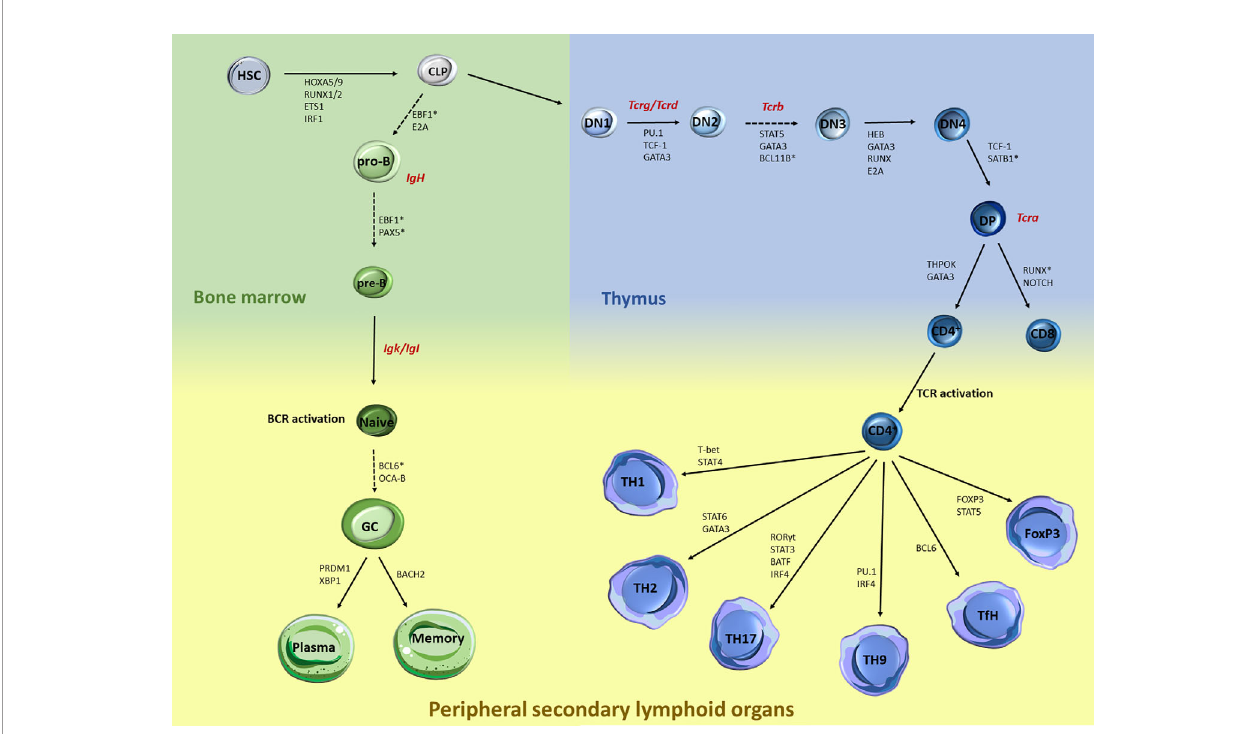
FIGURE 1 | Major stages during B and T lymphocyte speci fi cation and differentiation and key transcription factors that control each transition. B and T cell development and differentiation is a stepwise process that involves multiple speci fi cation steps, cell fate bifurcations and cell migration. Multiple TFs, including but not limited to those acting at the chromatin level, have been extensively documented in HSC. Within the bone marrow, the transition of CLP towards pro-B cells is mediated through EBF1 and E2A, while the further maturation of the pre-B cells is under the control of EBF1 and PAX5. Upon BCR activation, BCL6 and OCA-B are controlling the differentiation of naive to GC cells, while the latest developmental stages are mediated through BACH2 for memory B cells and PRDM1 and XBP1 for plasma cells. Similarly, T cell development is also regulated by a strong network of TF, cytokines and genome organizers that control chromatin dynamics and T cell lineage speci fi cation. Upon thymocyte migration, the early steps of the thymocyte development are mediated through the genome organizers SATB1 and BCL11B while TF such as PU.1, TCF1 and GATA3 mediate the generation of the DN1 cells. The transition from the DN2 to DN3 is mediated by the STAT5, GATA3 and BCL11B, while RUNX, GATA3, HEB and E2A mediate the DN3 and DN4 transition. TCF-1 is also the major TF driving the DN4 to DP transition. The last steps of the intrathymic development are mediated through the expression of ThPOK and GATA3 for the CD4 + cells and NOTCH and RUNX for the CD8 + cells. Upon TCR activation, expression of the master regulator T-bet via STAT4 signaling leads to TH1 differentiation, while STAT6 and GATA3 regulate the TH2 differentiation. Activation of STAT3 and ROR g leads to TH17 cells, while IRF4 and PU-1 induce the differentiation towards TH9 cells. Activation of Bcl-6 induces the differentiation of naive CD4 + T cells into TfH. Differentiation of the Tregs is controlled by the transcription factor Foxp3 and STAT5. Generation of Tcr/Ig receptor diversity through VDJ recombination takes place at various stages during B/T lymphocyte development as depicted